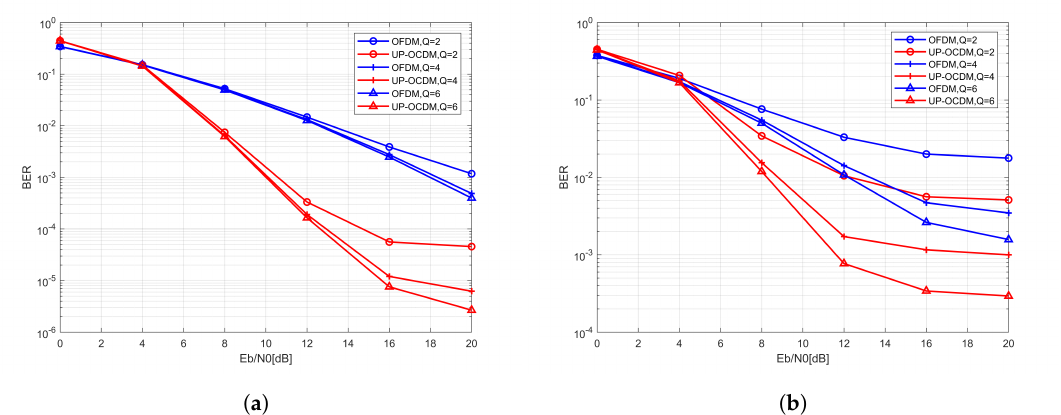
Figure 3. BER performance of the UP-OCDM and OFDM systems with band MMSE block equalizers under different bandwidth Q with the normalized Doppler spread of 0.1 ( a ) and 0.3 ( b